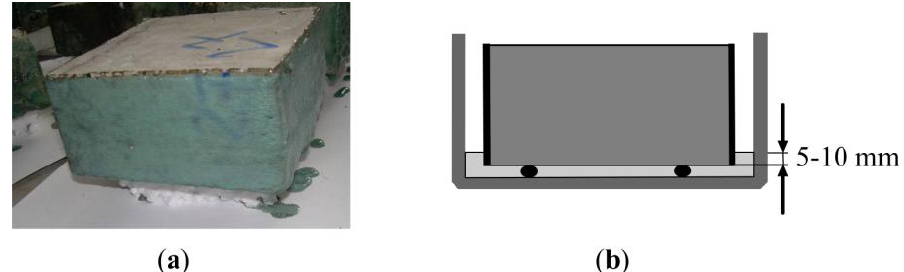
Figure 2. Sample view during frost resistance test: ( a ) view of the sample reinforced with polyester resin and fibre; ( b ) test scheme.